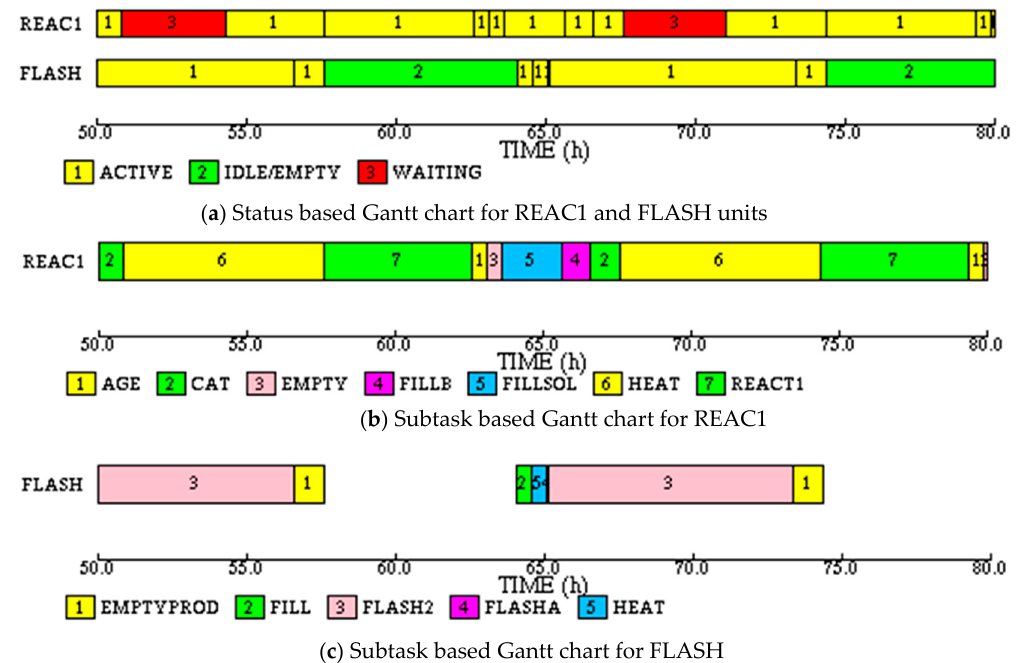
Figure 14. Subtask and status based Gantt charts for REAC1 and FLASH for base case.